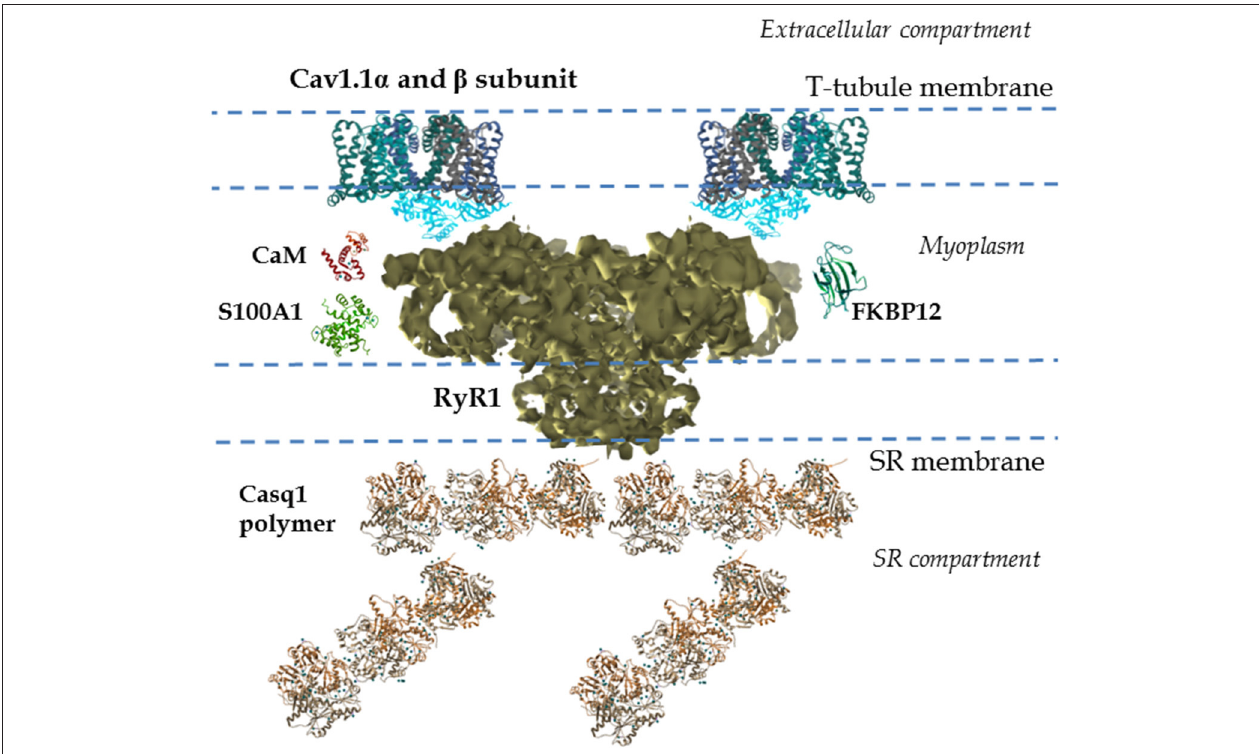
FIGURE 2 | Cav1.1-RyR1 complex: molecular details. Shown is a reconstruction from cryo-electron microscopy of the mammalian RyR1 at 4.8 Å illustrating the different regions. This includes the large myoplasmic segment and its multiple cavities and processes, and the SR transmembranal segment, which forms the Ca 2 + conduction pathway (Electron microscopy data bank entry 6106, Zalk et al., 2015). The above properties allow the RyR1 to interact with multiple SR luminal and cytosolic proteins. Several 3-D structures of proteins interacting with RyR1, as well as their relative locations, are also shown. EMData bank PDB entry and